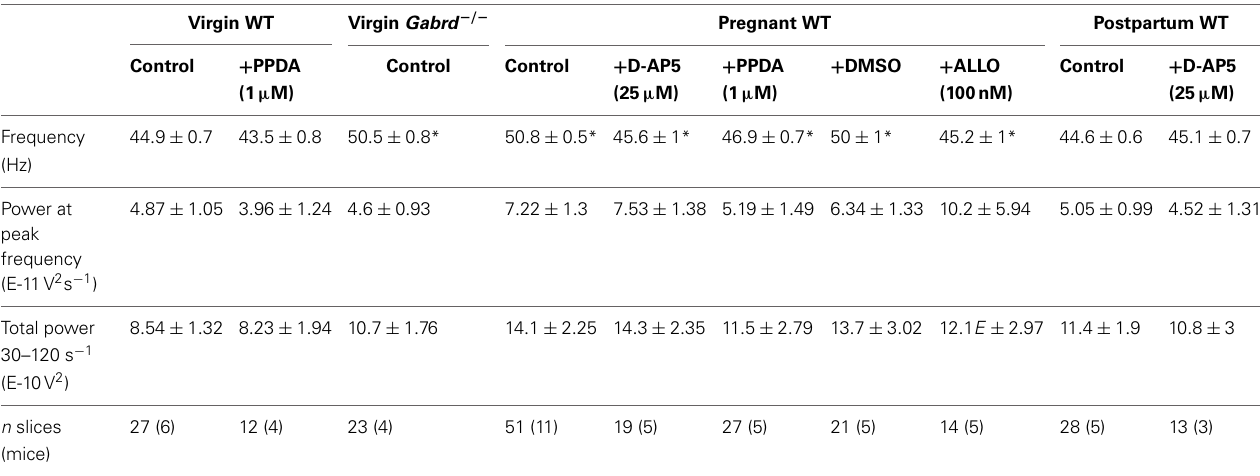
Summary of mean values and SEM for each of the gestational states and genotypes derived from the corresponding 180s period averages power spectral densities. γ oscillations were characterized by their peak frequency, power at peak frequency and total power (30–120Hz). Asterisks denote significance calculated by One-Way ANOVA followed by Turkey’s multiple comparisons test (for controls), or two-tailed paired t-test (for DAP-5 and PPDA treatment), or two-tailed unpaired t-test (for DMSO and ALLO